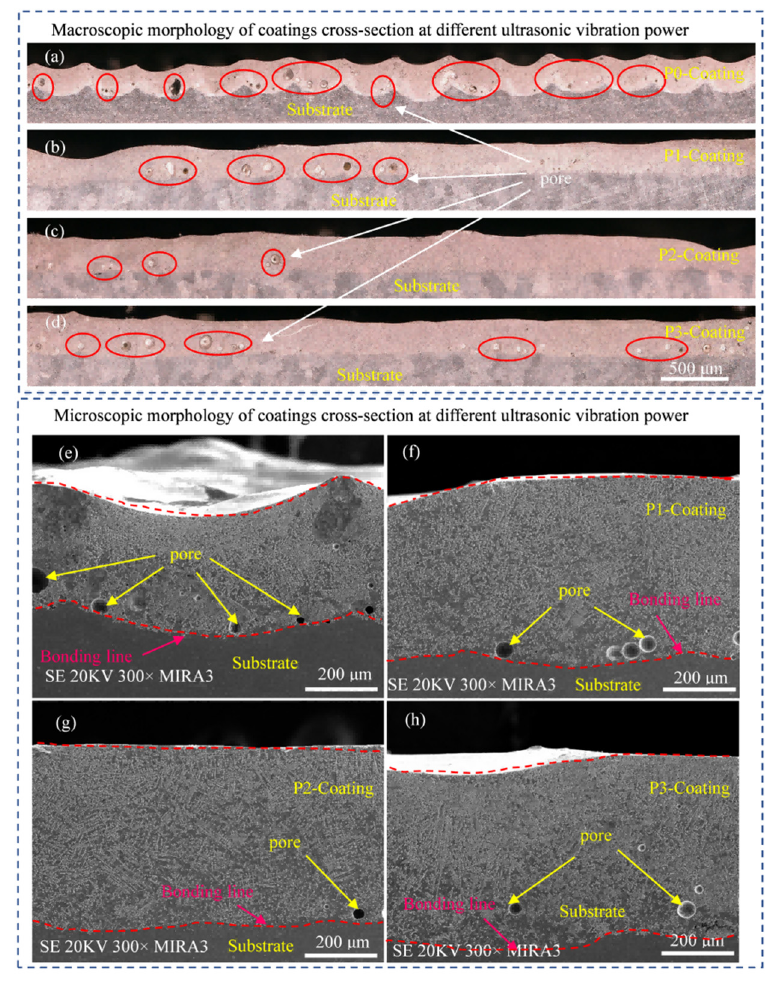
Figure 4. The cross-section morphology images of coatings fabricated with different ultrasonic vibration power: Macroscopic: ( a ) P0-Coating, ( b ) P1-Coating, ( c ) P2-Coating, ( d ) P3-Coating; Micro- scopic: ( e ) P0-Coating, ( f ) P1-Coating, ( g ) P2-Coating, ( h ) P3-Coating.